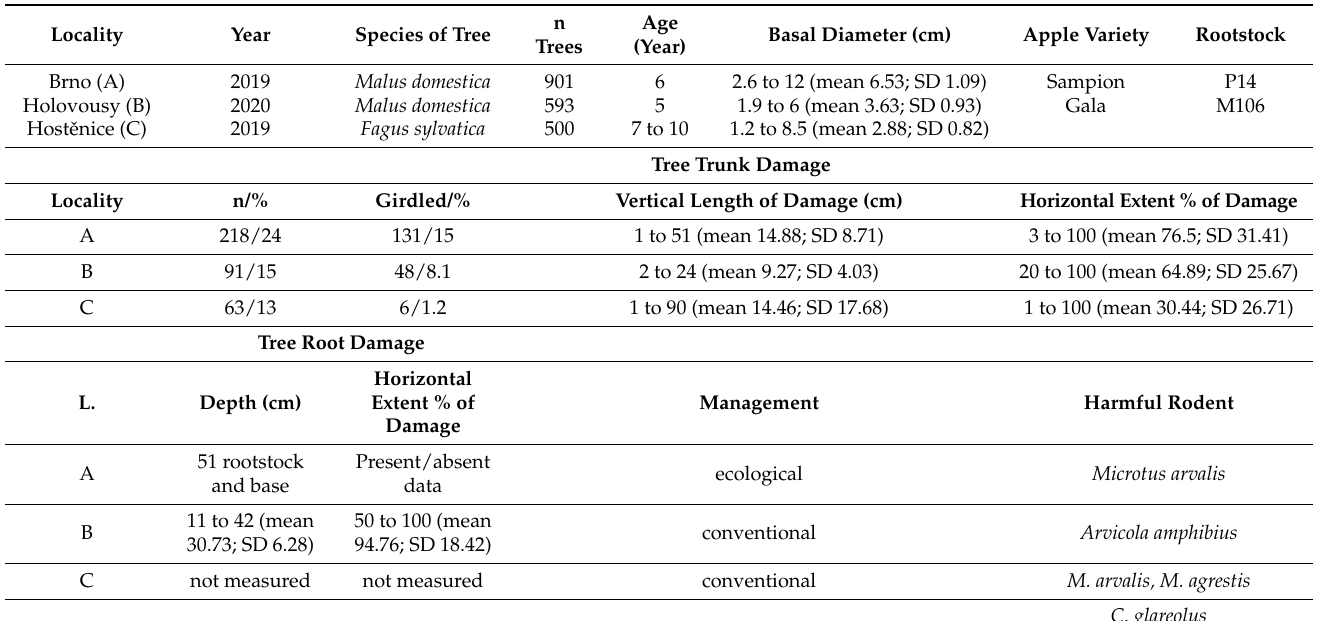
Table 1. Collected data on young trees and damage by